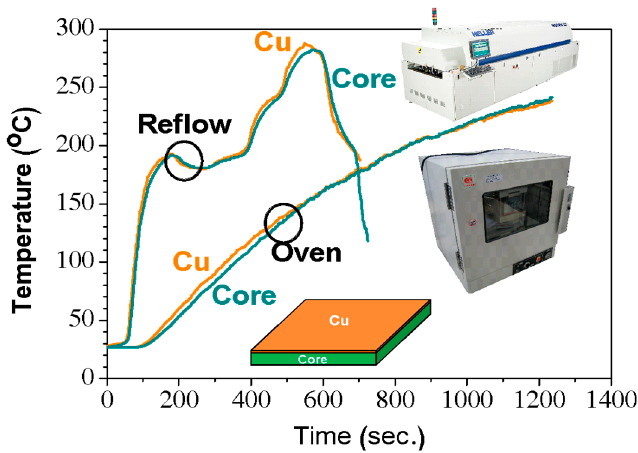
Figure 5. Temperature profiles on the Cu/core bi-material specimen in an IR reflow oven (with a specimen moving velocity of 0.2 m/min) and in a conventional oven.